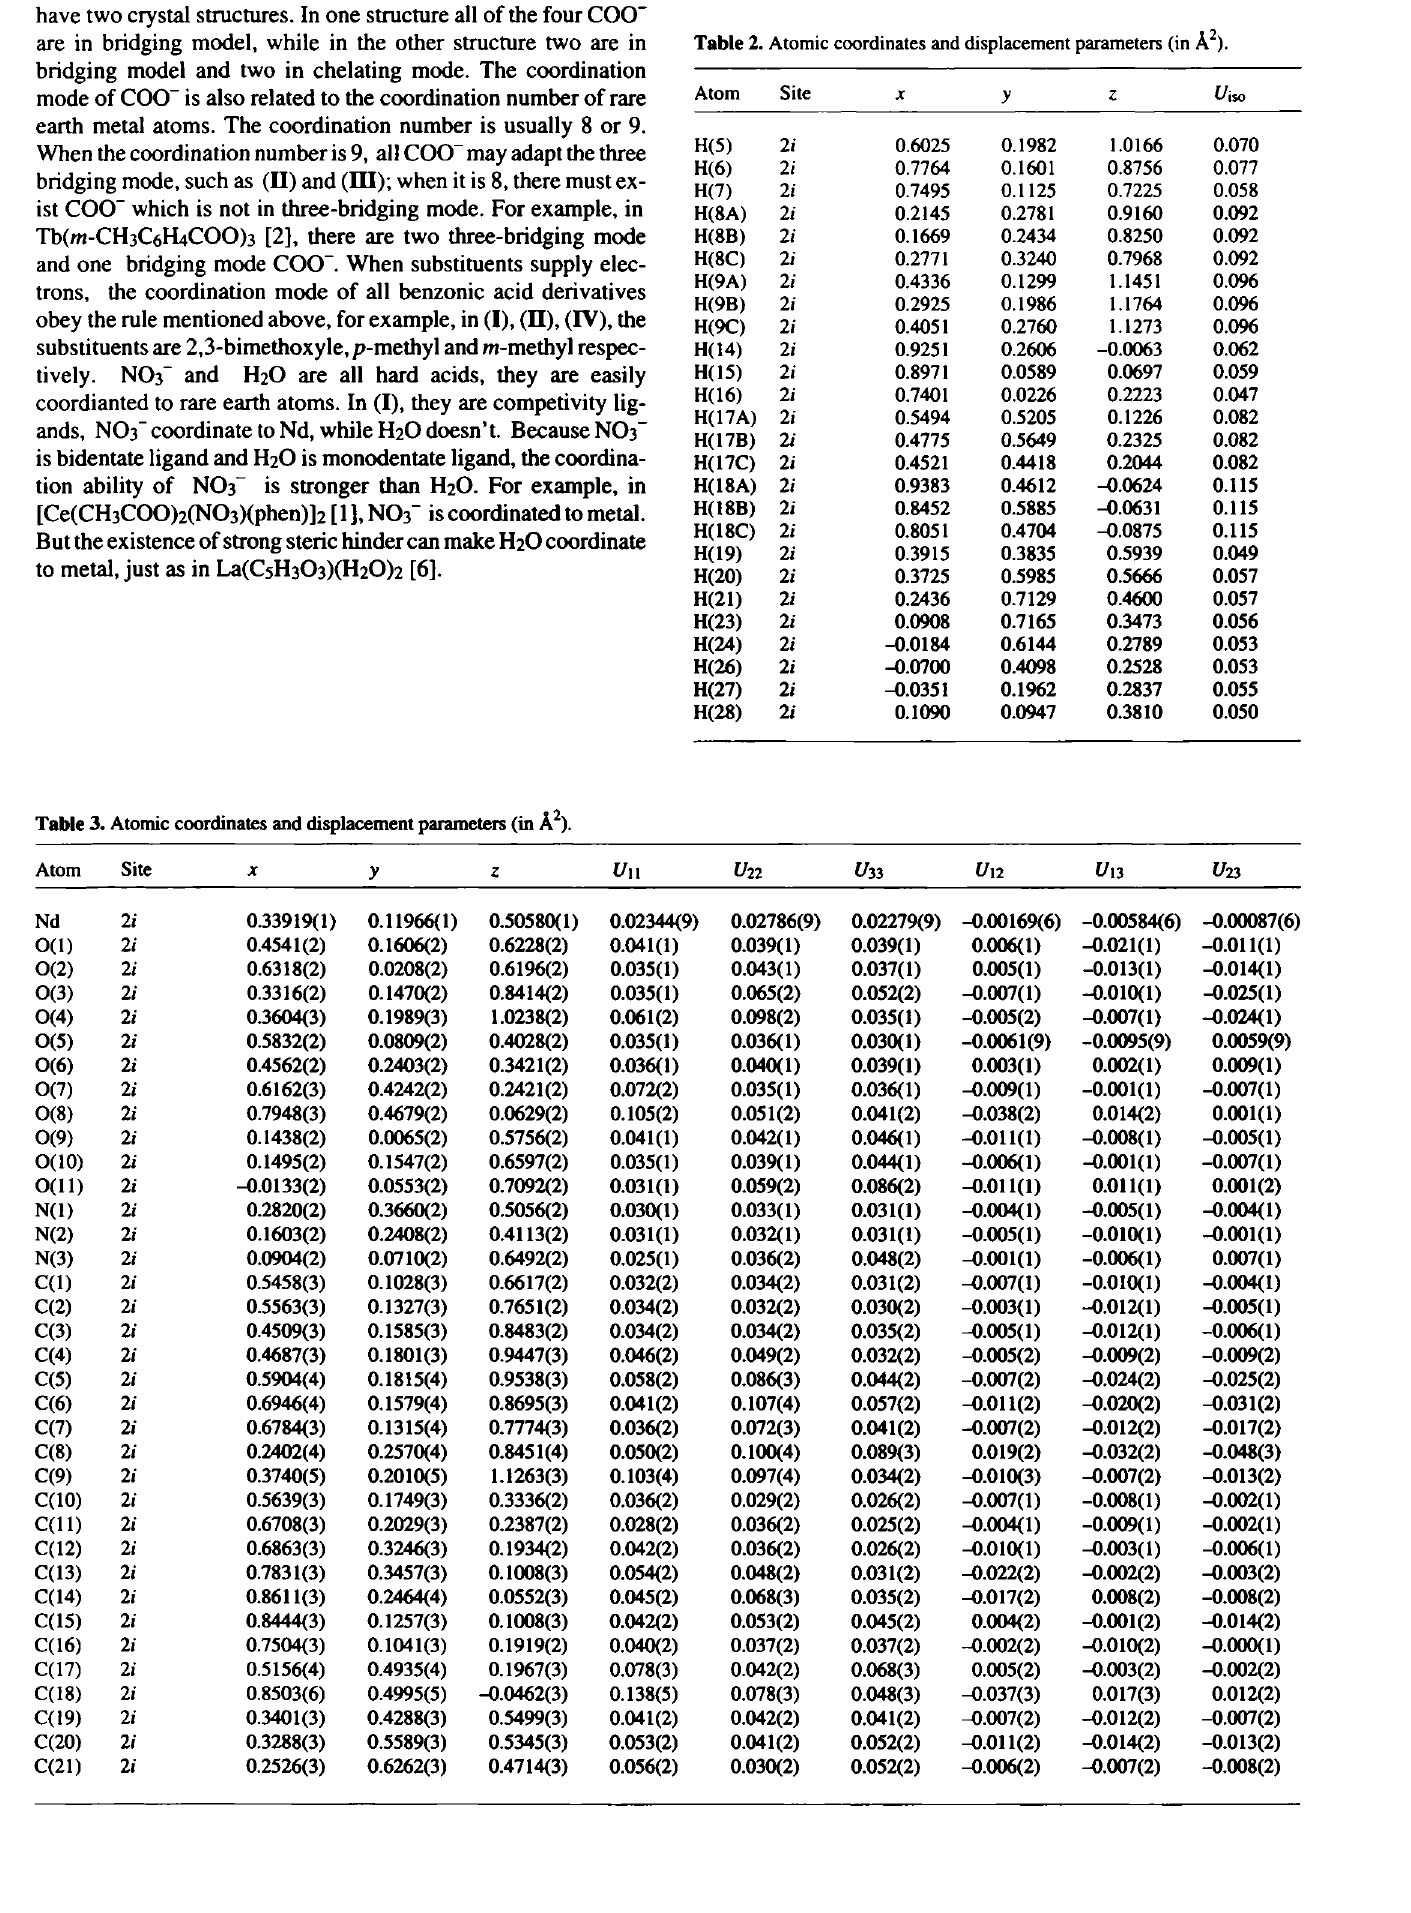
Table 2. Atomic coordinates and displacement parameters (in À 2 ).